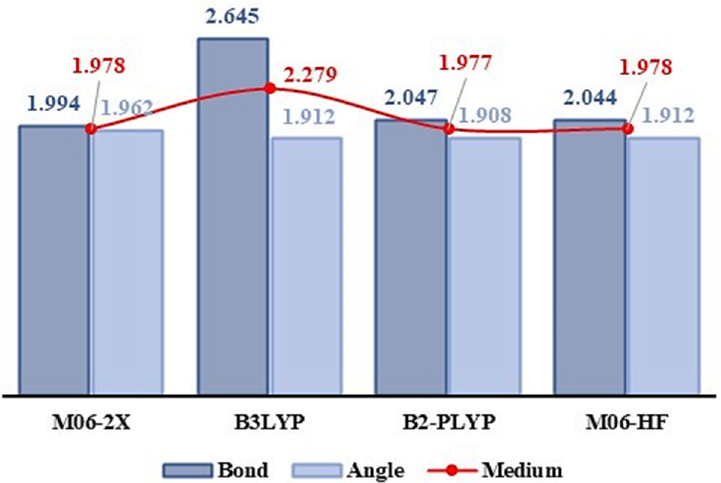
Figure 2. Graph of the mean absolute deviations for geometric parameters obtained by the exchange and correlation functionals M06-2X, B3LYP, B2-PLYP, and M06-HF (compared to experimental results).